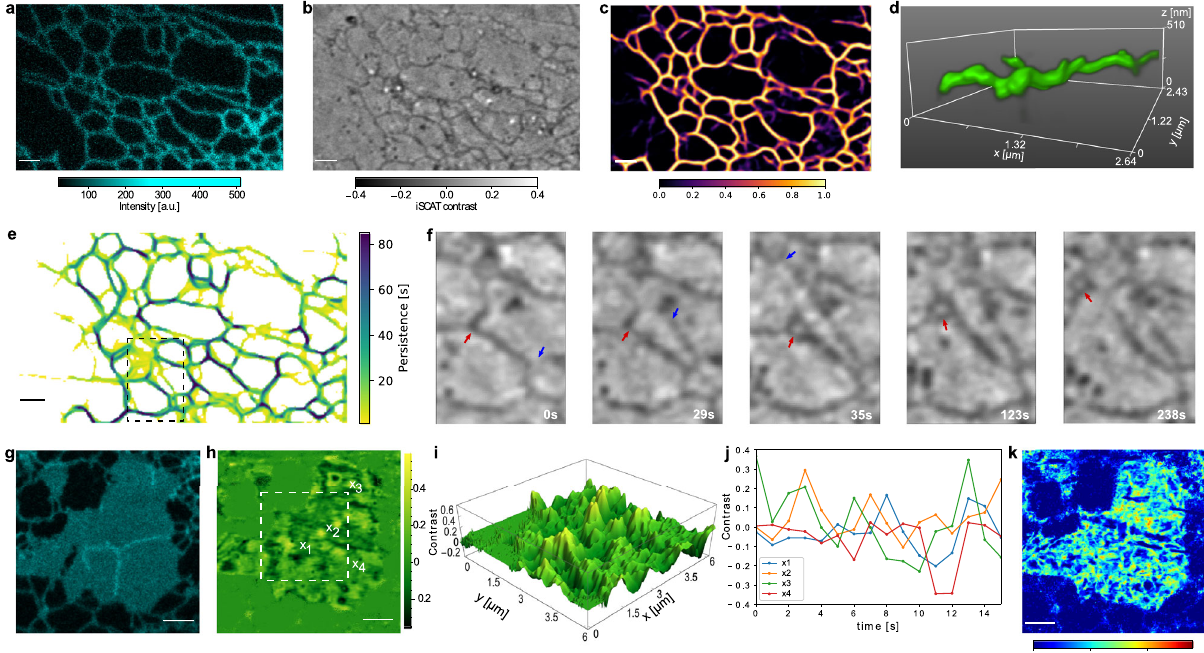
Fig. 3 | Structure and dynamics of the endoplasmic reticulum. a Fluorescence image of the ER network in a COS-7 cell that was transfected with ER-EGFP. b Simultaneouslyrecordedbackground-correctedC-iSCATimage.ERtubulesinthe cellularperipheryyieldameaniSCATcontrastof12%.Scalebarsin a and b are1 μ m. c Corresponding segmentation of ER after training a conditional generative adversarial network (cGAN). Color map encodes the prediction output of cGAN. d Rendered3Drepresentation of the tubularnetworkobtainedfroma z -stackover the range of 510nm recorded with Δ z =30nm. e Persistency map calculated using 340 frames over 85s with a lag period of 5s. The color code corresponds to the